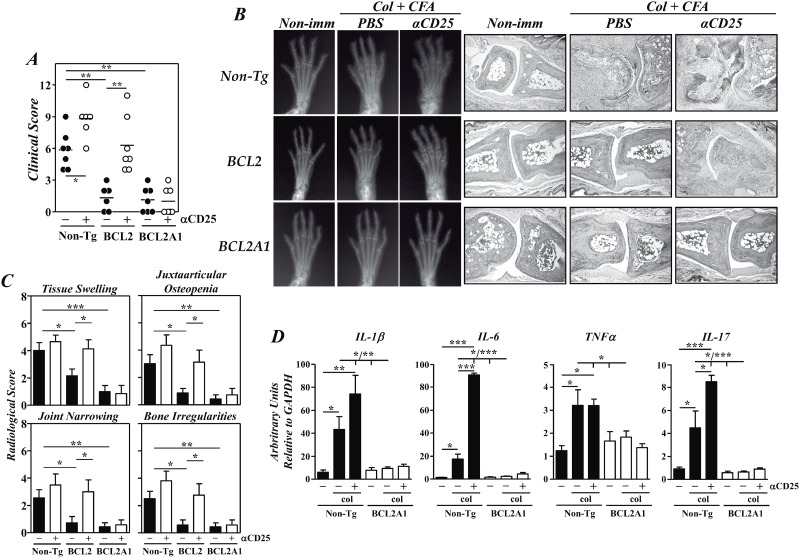
Protection against CIA in BCL2A1 Tg mice.Ten weeks-old F1-BCL2-TgT, F1-BCL2A1-TgT and control F1 non-Tg littermates, depleted or not of CD4+CD25+ Tregs after treatment with an anti-CD25 mAb, were immunized with col-II-CFA. (A) Clinical severity of arthritis in individual mice 8 weeks after col-II immunization. Bars represent mean values. (B) Representative radiological and histological (x10) images in the different experimental groups 8 weeks after immunization. (C) Radiological scores of different radiological signs associated with disease severity expressed as the mean ± SD. Results from A to C are representative of five independent experiments. (D) Expression of mRNAs encoding for arthritogenic cytokines in the paws of non-immunized and untreated or anti-CD25 treated col-II-CFA immunized F1 non-Tg mice (closed bars) and F1-BCL2A1-TgT (open bars) 8 weeks after immunization analyzed by RT-qPCR. Results are expressed as the mean ± SD fold change (n = 6–7 mice/group) of each cytokine relative to GAPDH expression measured in parallel in each sample. Statistic differences are indicated as follow: *p<0.05, **p<0.01, *** p<0.001. When not indicated, differences did not reach statistical signification.